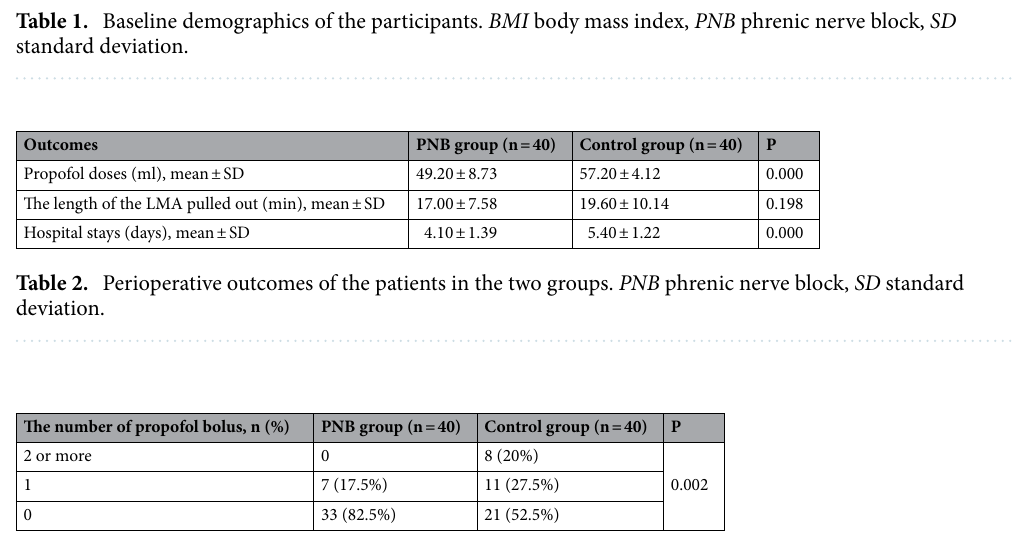
Table 3. The times of the propofol boluses. PNB phrenic nerve block.